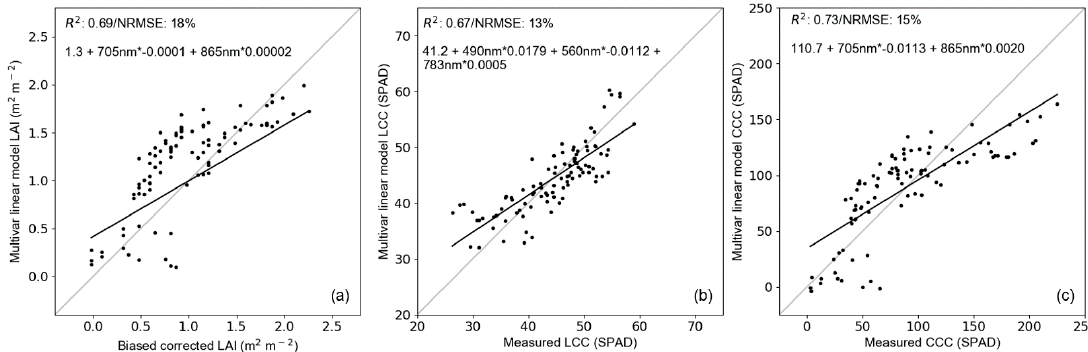
Figure 6. Independent evaluation of a multivariate linear regression model for ( a ) LAI, ( b ) LCC and ( c ) CCC. ( c )